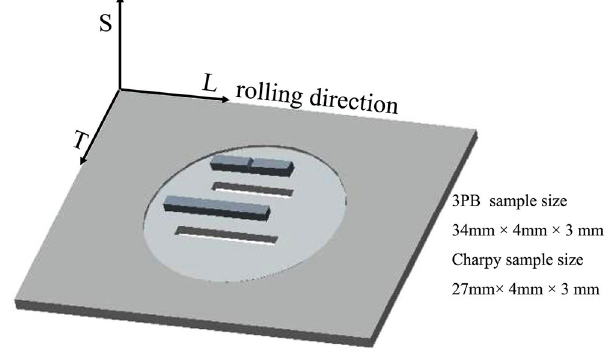
Figure 1. Cutting sketch of the specimens from SMATed WL10. Nomenclature of the sample orientation: “L” stands for longitudinal, “T” for transverse, and “S” for short